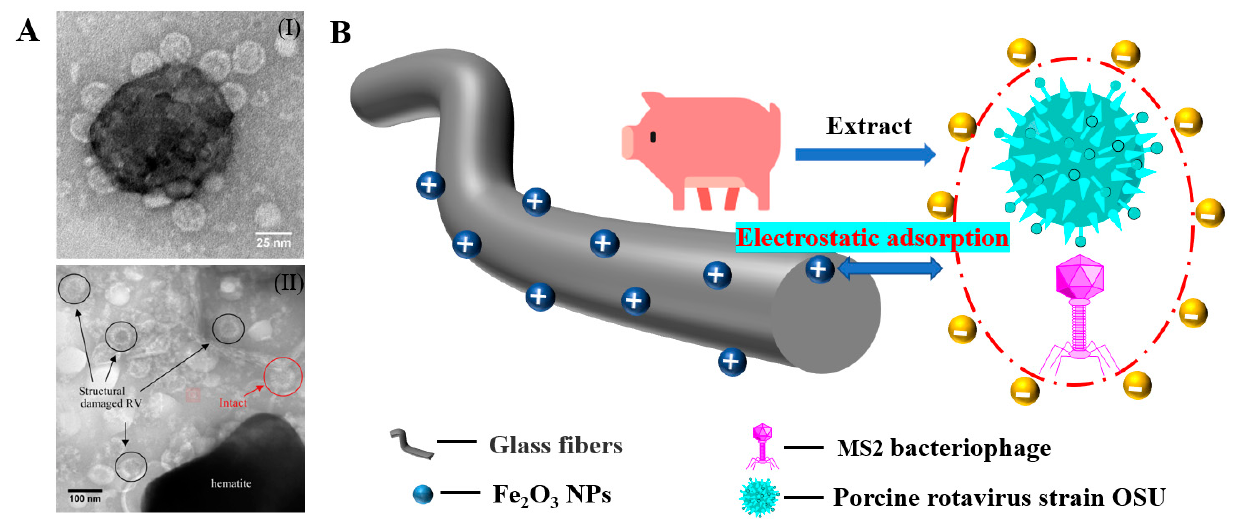
Figure 19. ( A ) ( I ) TEM image shows MS2 phages adsorbed to the surface of an aggregate of hematite nanoparticles. There was no noticeable decrease in the diameter of the viral particles, and their integrity did not appear to be compromised. ( II ) TEM image shows RV particles with compromised structure after coming into contact with hematite nanoparticles in solution. Reproduced with permission from reference [147]. Copyright 2009 Water Research . ( B ) Schematic diagram of hematite-coated fiber adsorption of rotavirus and phage by electrostatic action.